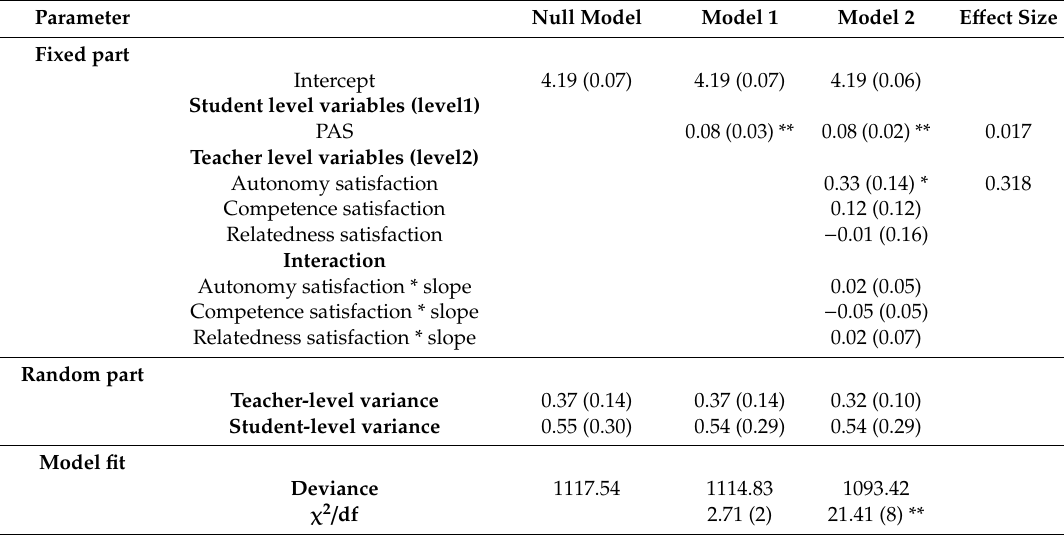
Table 2. Two-level multilevel analysis with behavioural engagement as a dependent variable and teacher’ need satisfaction as level-2